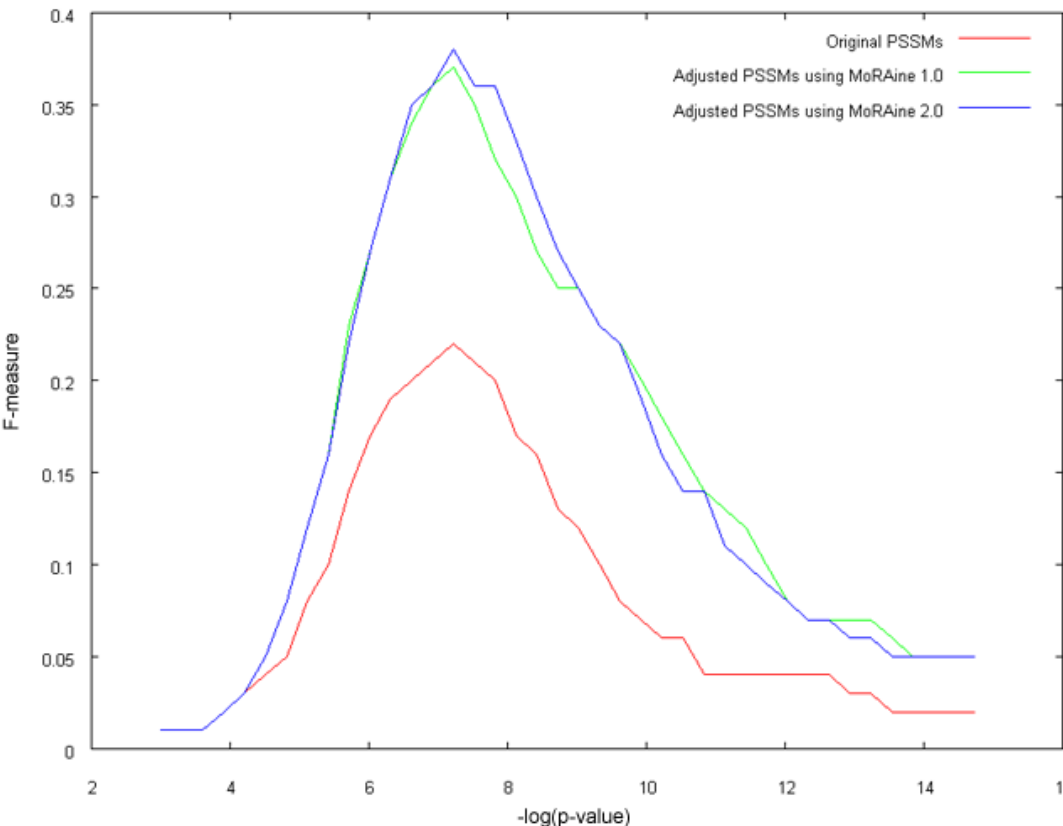
Figure 3: Prediction performance comparison by means of plotting the F-measure for varying PoSSuMsearch p-value thresholds for the original TFBSs (red line), the MoRAine 1.0-adjusted TFBSs (green line), and the MoRAine 2.0-adjusted TFBSs (blue line) allowing 4 shifts to the left and right